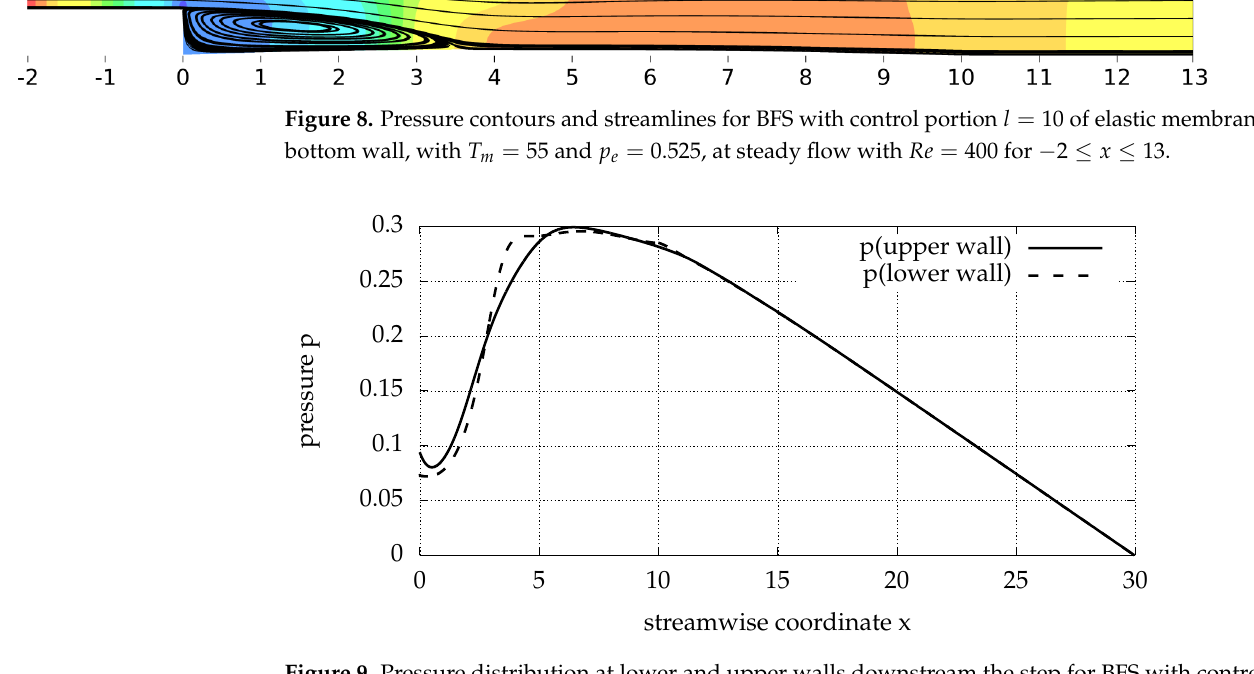
Figure 9. Pressure distribution at lower and upper walls downstream the step for BFS with control portion l = 10 of elastic membrane bottom wall, with T m = 55 and p e = 0.525, at steady flow with Re = 400.